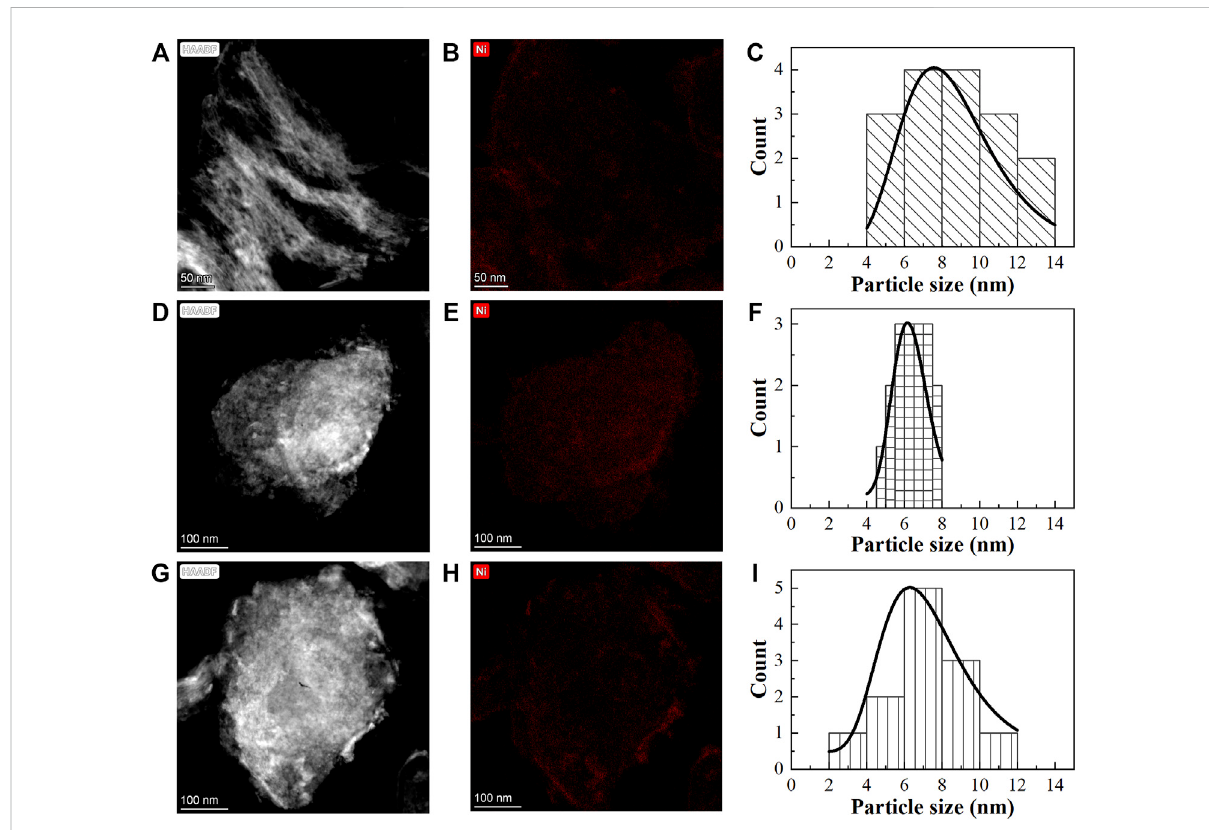
FIGURE 4 STEM images, EDX mapping and the corresponding nickel particle size distribution of (A – C) 10Ni/MgAl, (D – F) 10Ni-5La/MgAl and (G – I) 10Ni- 1K/MgAl (Ni particle size was determined by counting > 12